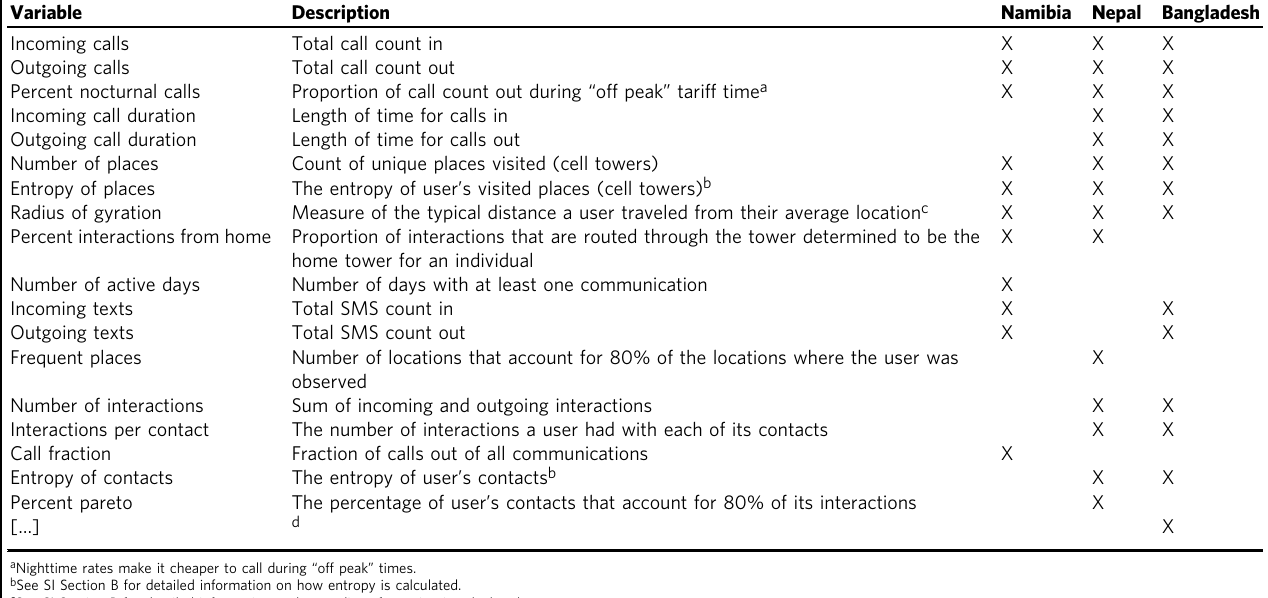
Table 2 CDR variables and their description in this study for each